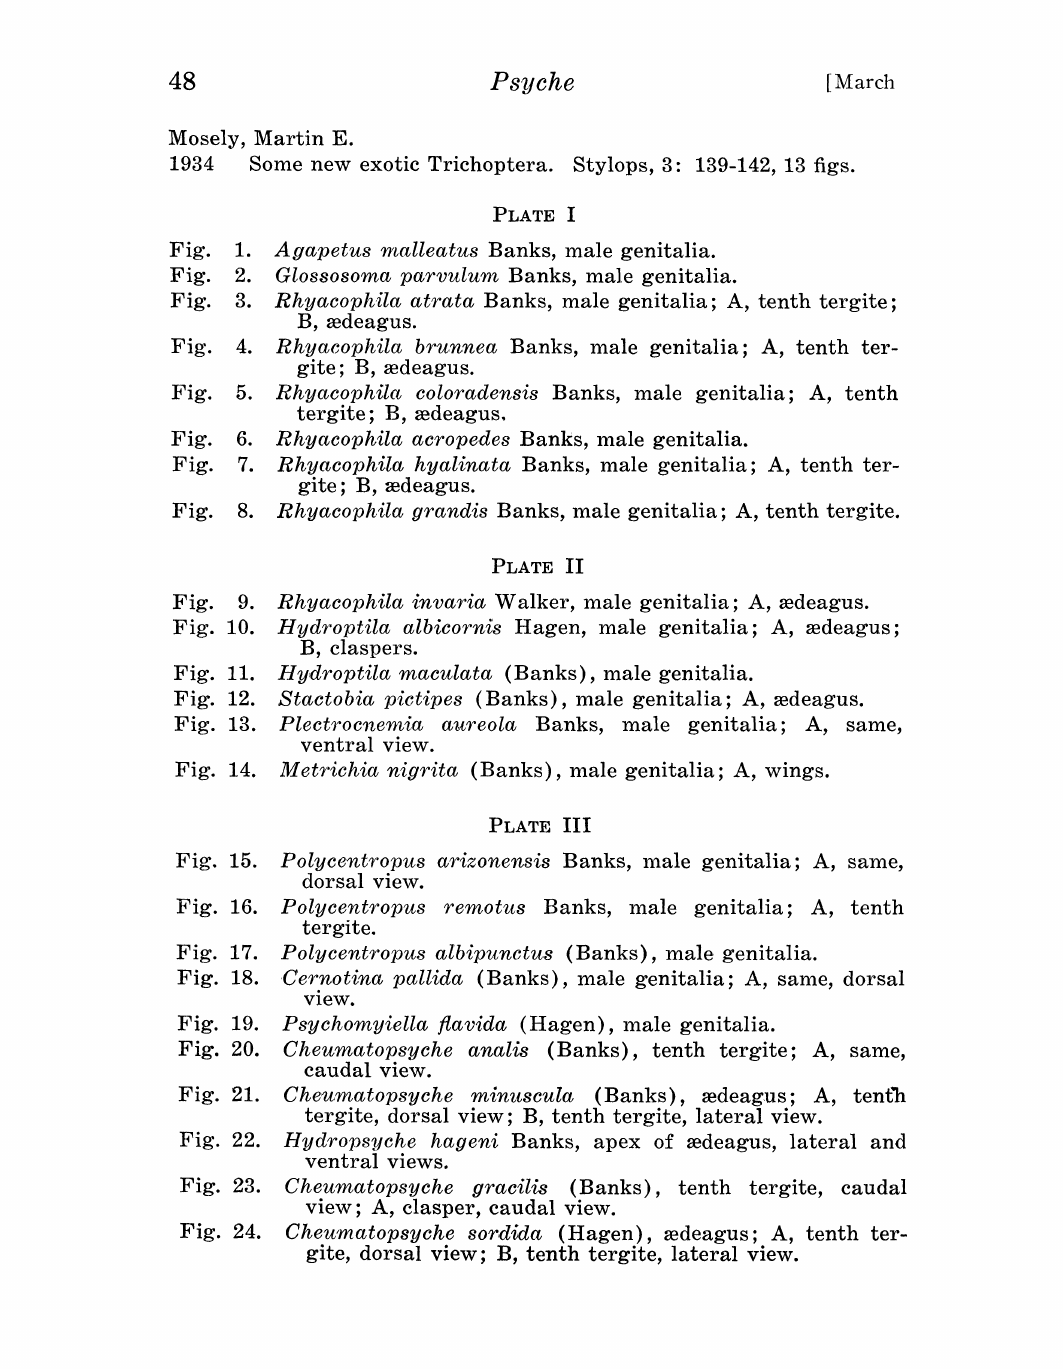
PLATE II Rhyacophila invaria Walker, male genitalia; A, mdeagus. Hydroptila albicornis Hagen, male genitalia; A, sedeagus; B, claspers. Hy.droptila maculata (Banks), male genitalia. Stactobia pictipes (Banks), male genitalia; A, mdeagus. Plectrocnemia aureola Banks, male genitalia; A, same, ventral view. Metrichia nigrita (Banks), male genitalia; A, wings. PLATE III Polycentropus arizonensis Banks, male genitalia; A, same, dorsal view. Polycentropus remotus Banks, male genitalia; A, tenth tergite. Polycentropus albipunctus (Banks), male genitalia. .Cernotina pallida (Banks), male genitalia; A, same, dorsal view. Psychomyiella flavida (Hagen), male genitalia. Cheumatopsyche analis (Banks), tenth tergite; A, same, caudal view. Cheumatopsyche minuscula (Banks), mdeagus; A, tenCn tergite, dorsal view; B, tenth tergite, lateral view. Hydropsyche hageni Banks, apex of mdeagus, lateral and ventral views. Cheumatopsyche gracilis (Banks), tenth tergite, caudal view; A, clasper, caudal view. Chewmatopsyche sor.dida (Hagen), mdeagus; A, tenth ter- gite, dorsal view; B, tenth tergite, lateral